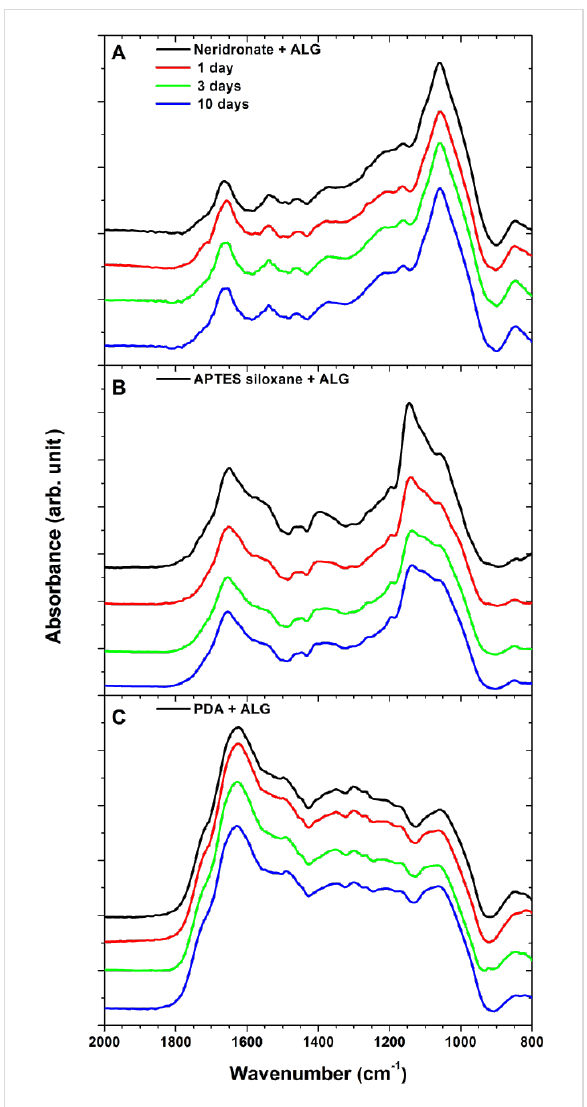
Figure 8: Evolution of IRRAS spectra of ALG bound to neridronate (A), to APTES siloxane (B) and to PDA (C) upon immersion in PBS at 37 °C for 7